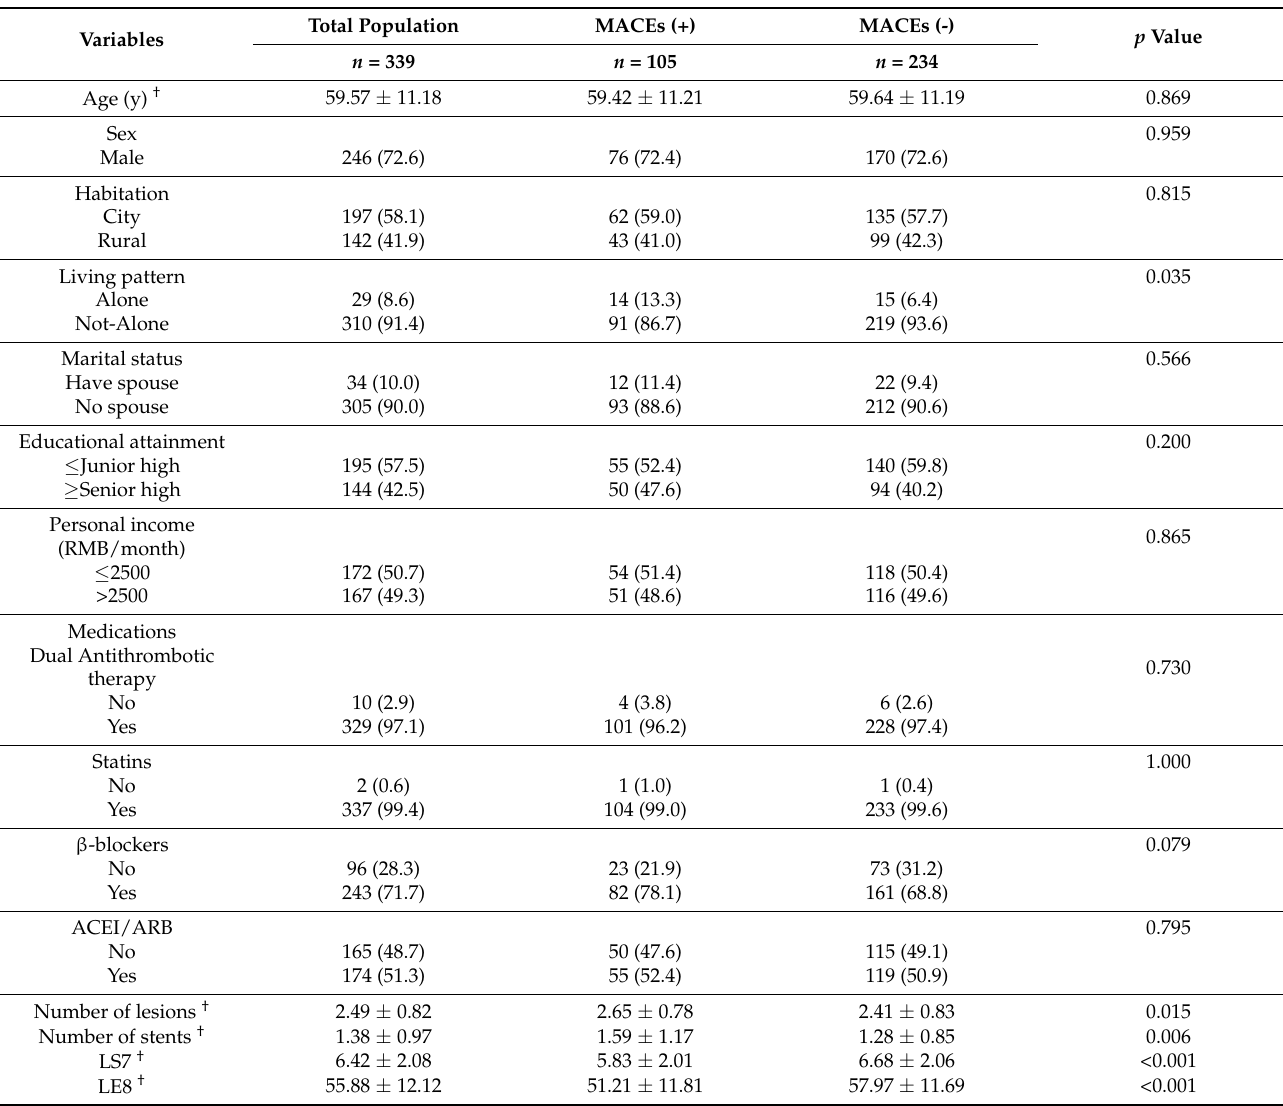
Table 1. Patients Demographics and Baseline Clinical Characteristics ( n =